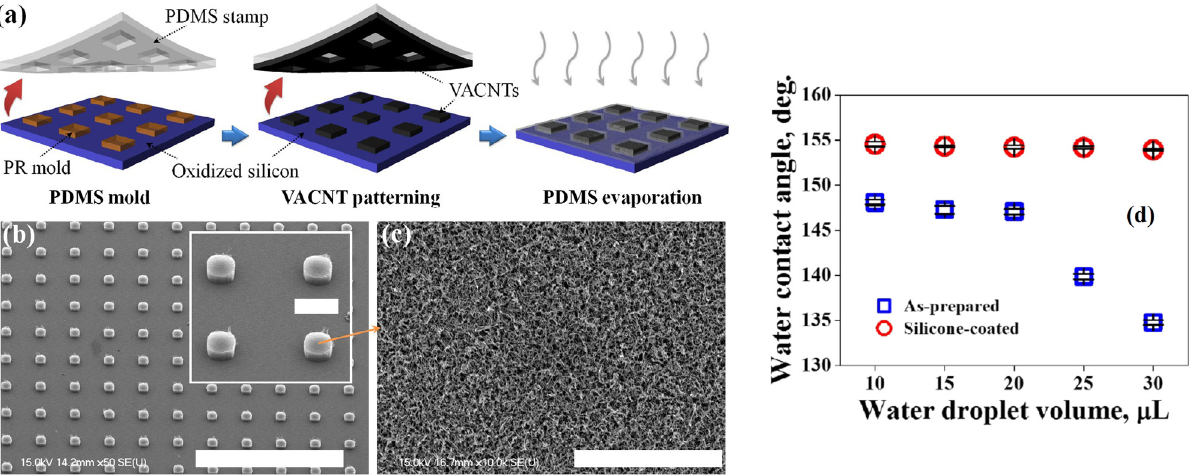
Figure 2: ( a ) Scheme showing fabrication steps of hierarchical VACNT SHPC surface. ( b ) SEM image of the CNT micro - pillar arrays. Scale bars correspond to 1 mm and 100 µm ( inset ) . ( c ) Enlarged view of the pillar top. ( d ) CA variation with water - droplet volume [ 73 ] . Reproduced with permission from ref. [ 73 ] ; © 2014 Elsevier Ltd.